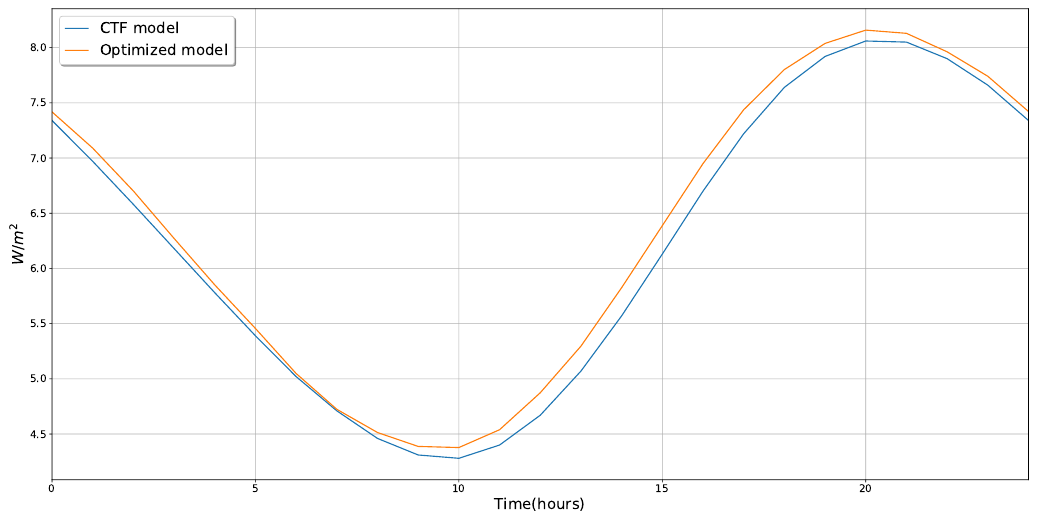
Figure 7. Comparison between CTF and simplified thermal network